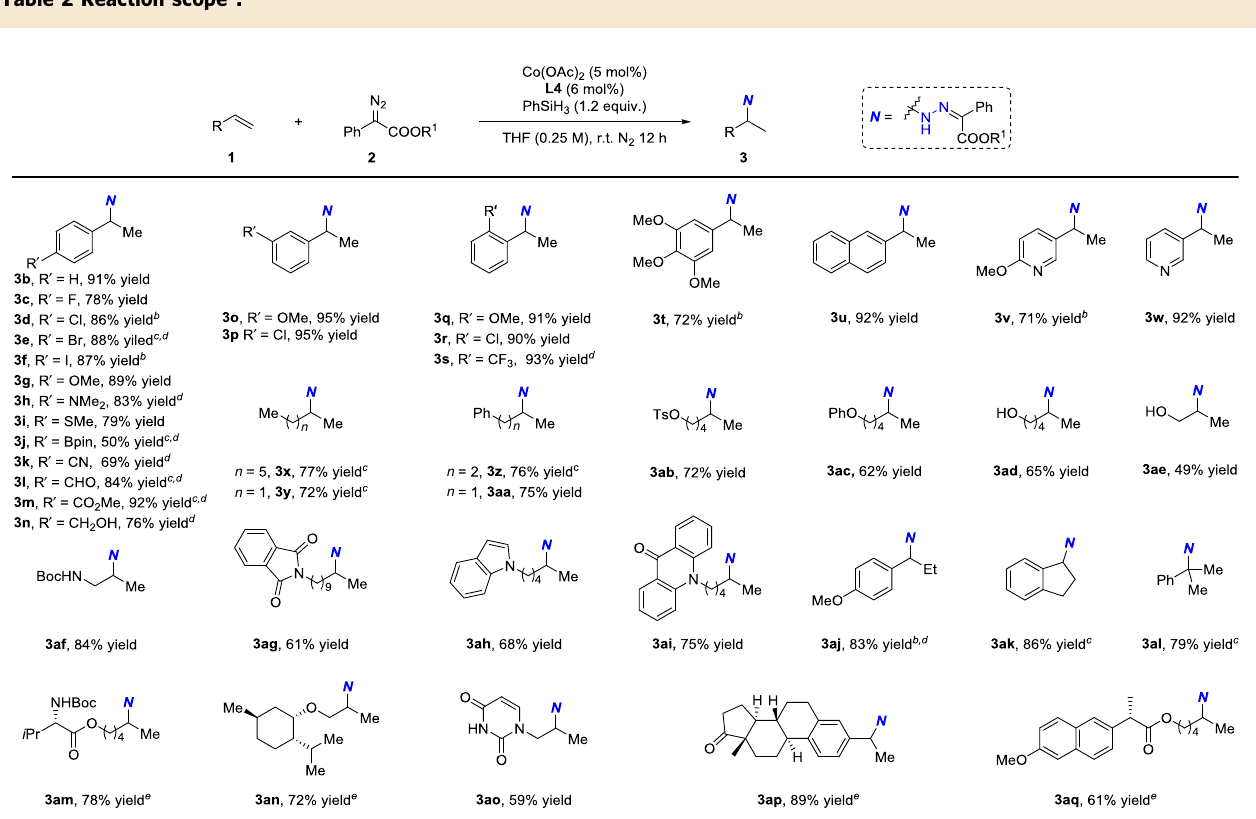
Table 2 Reaction scope a